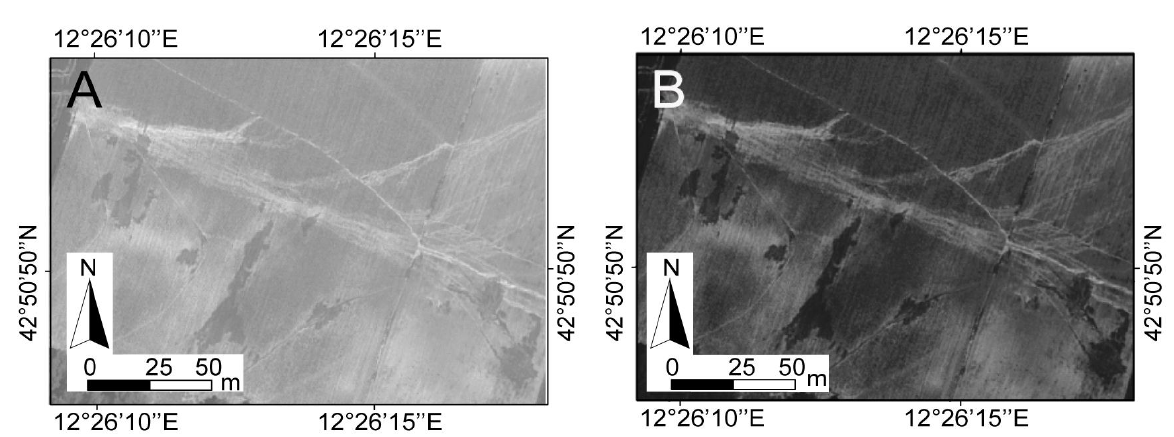
Figure 4. ( A ) Example of a ploughed field on an unstretched image and ( B ) on the enhanced image that was obtained by stretching the histogram values of the scene.